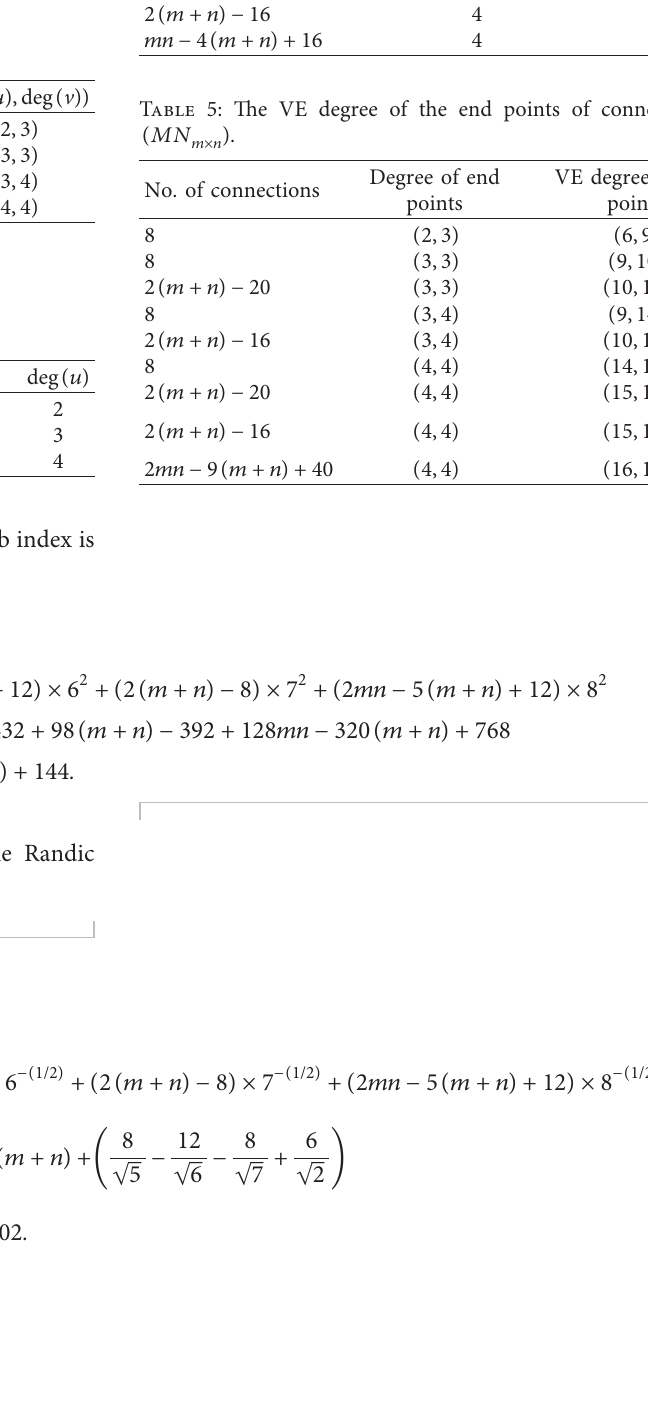
Figure 1: Mesh network ( MN )